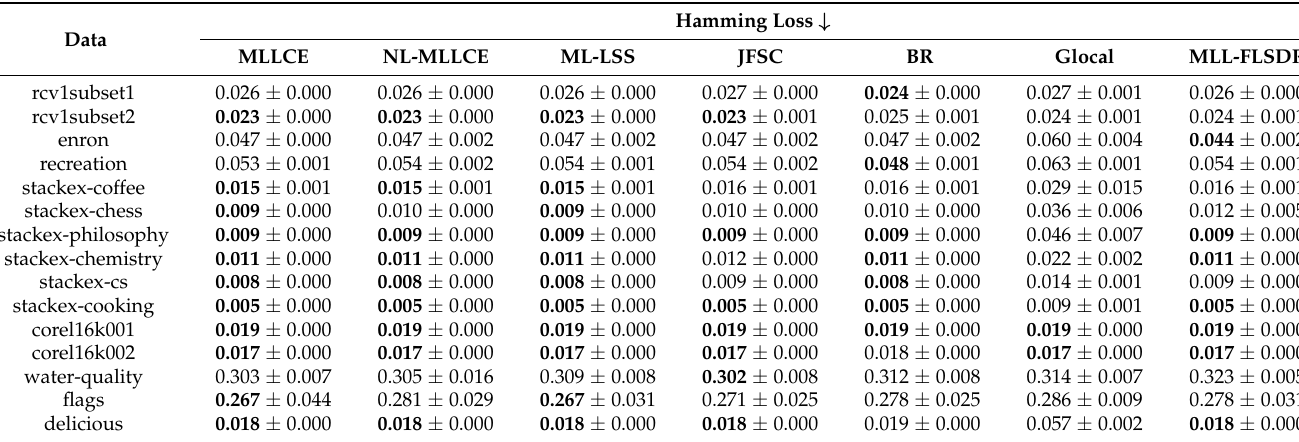
Table 2. The experimental results (mean ± standard) of all comparison methods in this paper in terms of Hamming Loss. ↓ means that the smaller the value, the better the performance is. The best results in each row are highlighted in bold face. Hamming Loss ↓ Data MLLCE NL-MLLCE ML-LSS